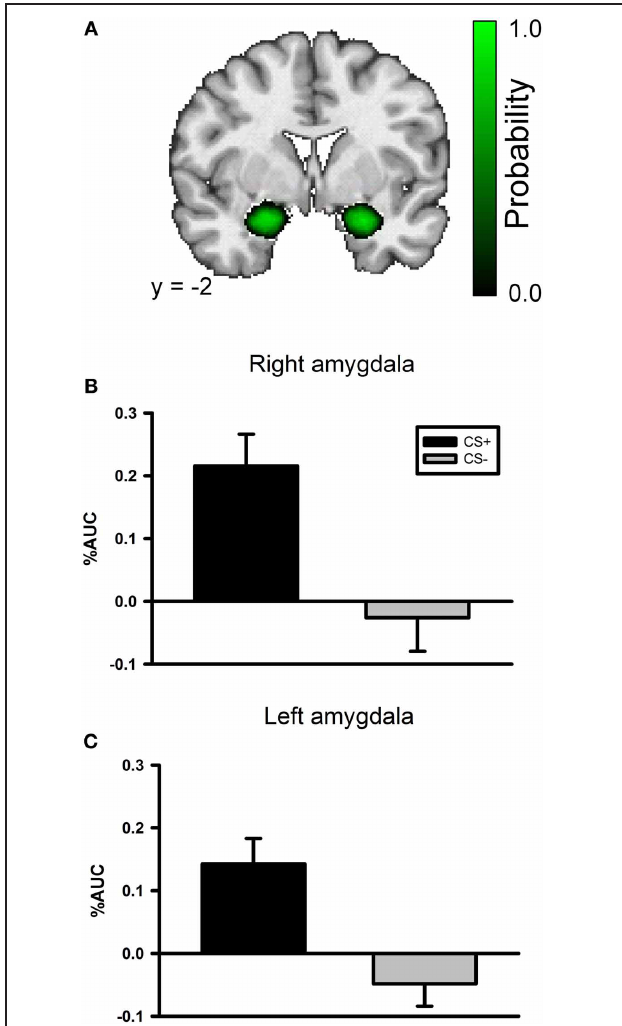
FIGURE 3 | The left and right amygdala both demonstrate differential responses to the CSs in the conditioning phase of the experiment. (A) An amygdala probability mask created by combining each participant’s anatomical amygdala ROI. The color scale corresponds to the probability that the region is included in any of the participants’ amygdala ROIs. Black indicates a low probability and bright green indicates high probability. (B) Bar graph depicting the AUC values for both the CS + and CS − evoked BOLD response in the right amygdala during the conditioning task. (C) Bar graph depicting the AUC values for both the CS + and CS − evoked BOLD response in the left amygdala during the conditioning task.